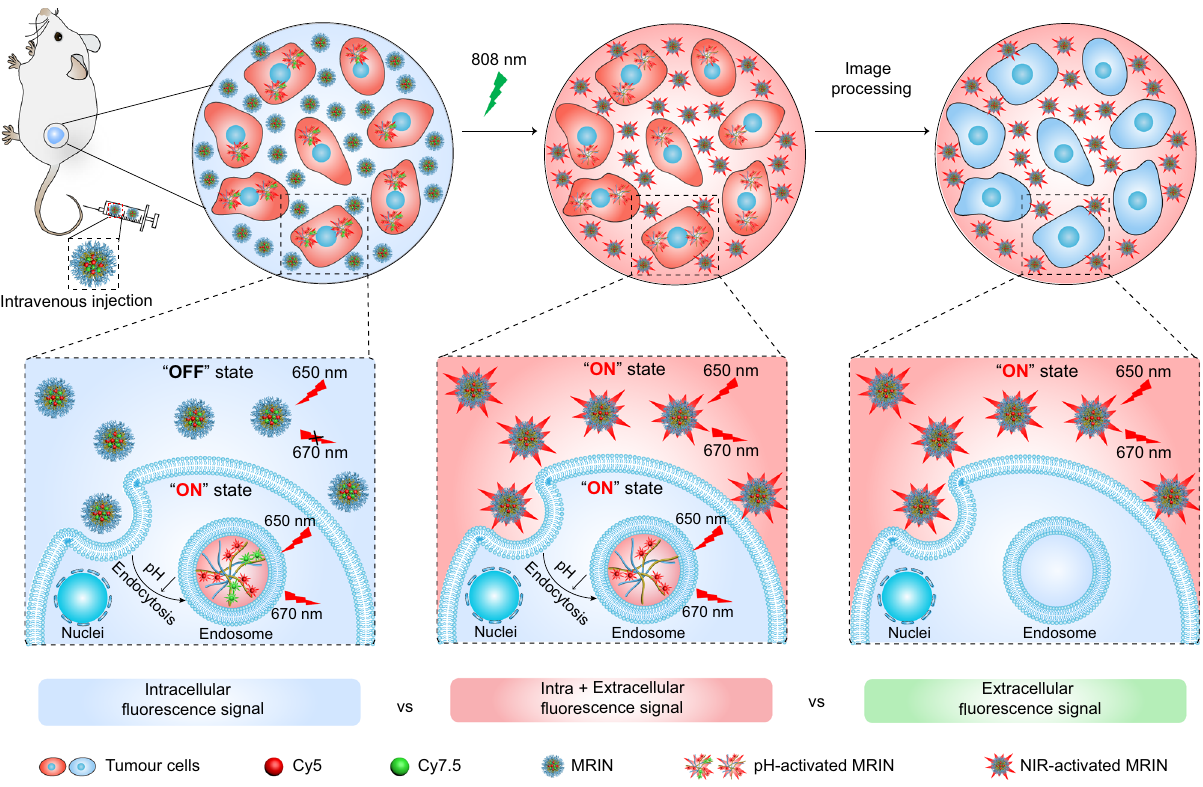
Fig. 1 Schematic illustration of the monochromatic ratiometric imaging for quantifying extracellular and intracellular distribution of nanoparticles in living mice. When accumulating at tumor tissues after intravenous injection, a part of MRINs are endocytosed into cells, then the Cy5 signals of intracellular nanoparticles are activated by the acidic pH of endosome. While the Cy5 signals of extracellular nanoparticles still keep ‘ OFF ’ state, which could be subsequently activated by 808 nm irradiation-induced Cy7.5 photobleaching. Harnessing MRIN nanotechnology, we can accurately quantify the intracellular and total (intracellular + extracellular) exposure of nanoparticles in tumor sites, thereby quantify the extracellular exposure of nanoparticles in tumor